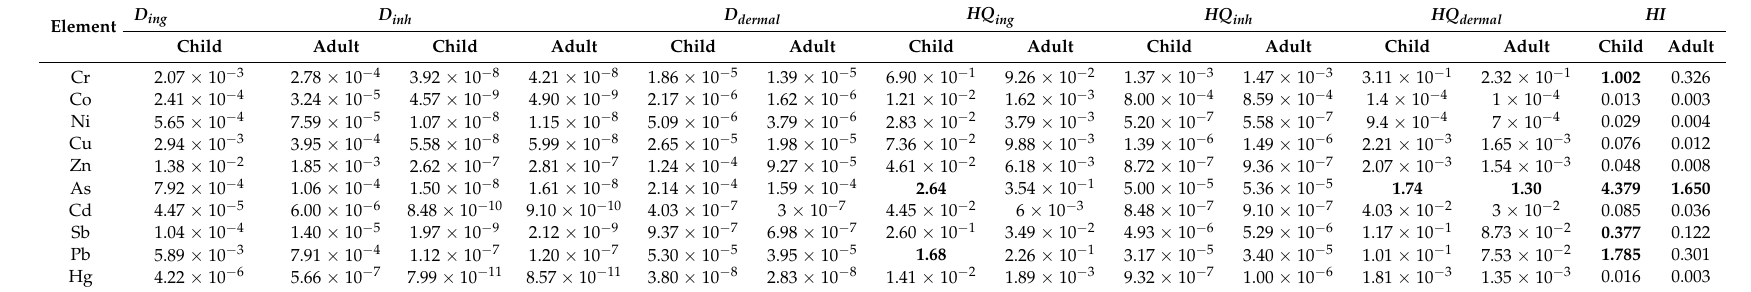
Note: Exposure dose, hazard quotients, and hazard index higher than 1 are shown in